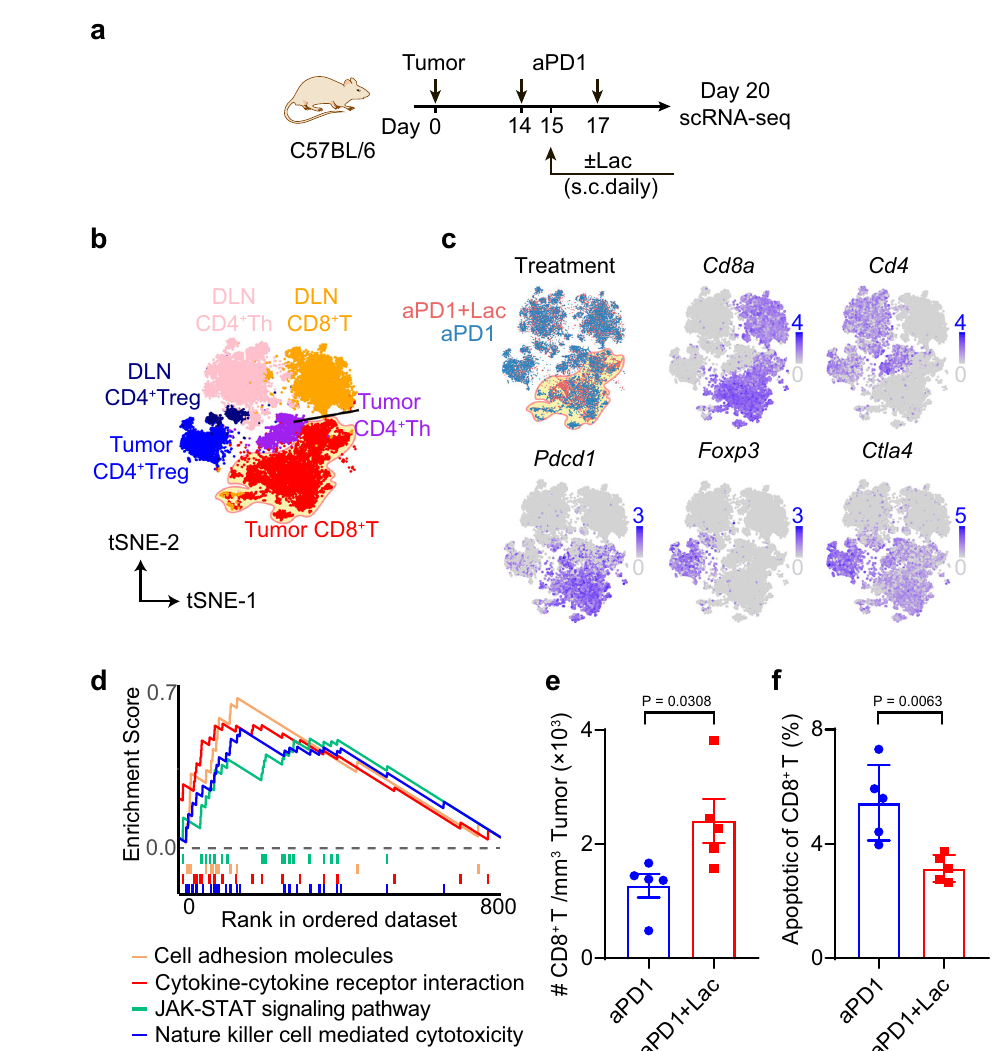
Fig. 3 | Lactate treatment increases in fi ltrating CD8 + T cells in MC38 tumors. a Experimental design of single cell transcriptomic analysis of anti-PD-1 with or without lactate. C57BL/6 mice were inoculated with 1×10 6 MC38 tumor cells and treated with anti-PD-1 (10mg/kg, day 14 and 17) and lactate (1.68g/kg, s.c. daily from day 15to 19).Tumor and tumor draining lymphnodes were harvestedon day 20and analyzedby single cellRNAsequencing using the 10x platform. b tSNE plot ofTcellclusterswithlocationandcelltypeinformationanalyzedwithSeuratv3.0.1. DLN: tumor draining lymph nodes. c Distribution of T cells from different treat- ments and expression of marker genes. d Signi fi cantly upregulated pathways in